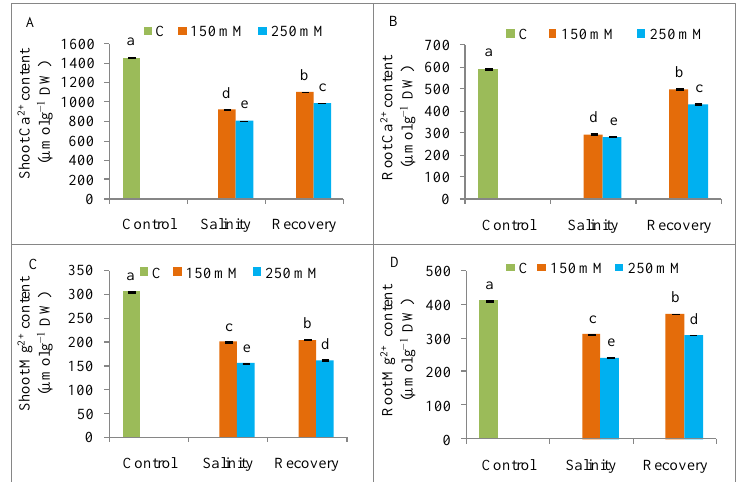
Figure 5. Content of Ca 2 + and Mg 2 + ( A ) shoot Ca 2 + , ( B ) root Ca 2 + , ( C ) shoot Mg 2 + , and ( D ) root Mg 2 + in tomato plants under salinity (150 and 250 mM NaCl) and after a 48 h recovery period. Data means ( ± SD) were calculated from three replications. Statistically significant values are indicated by dissimilar letters (Fisher’s LSD test, P ≤ 0.05).